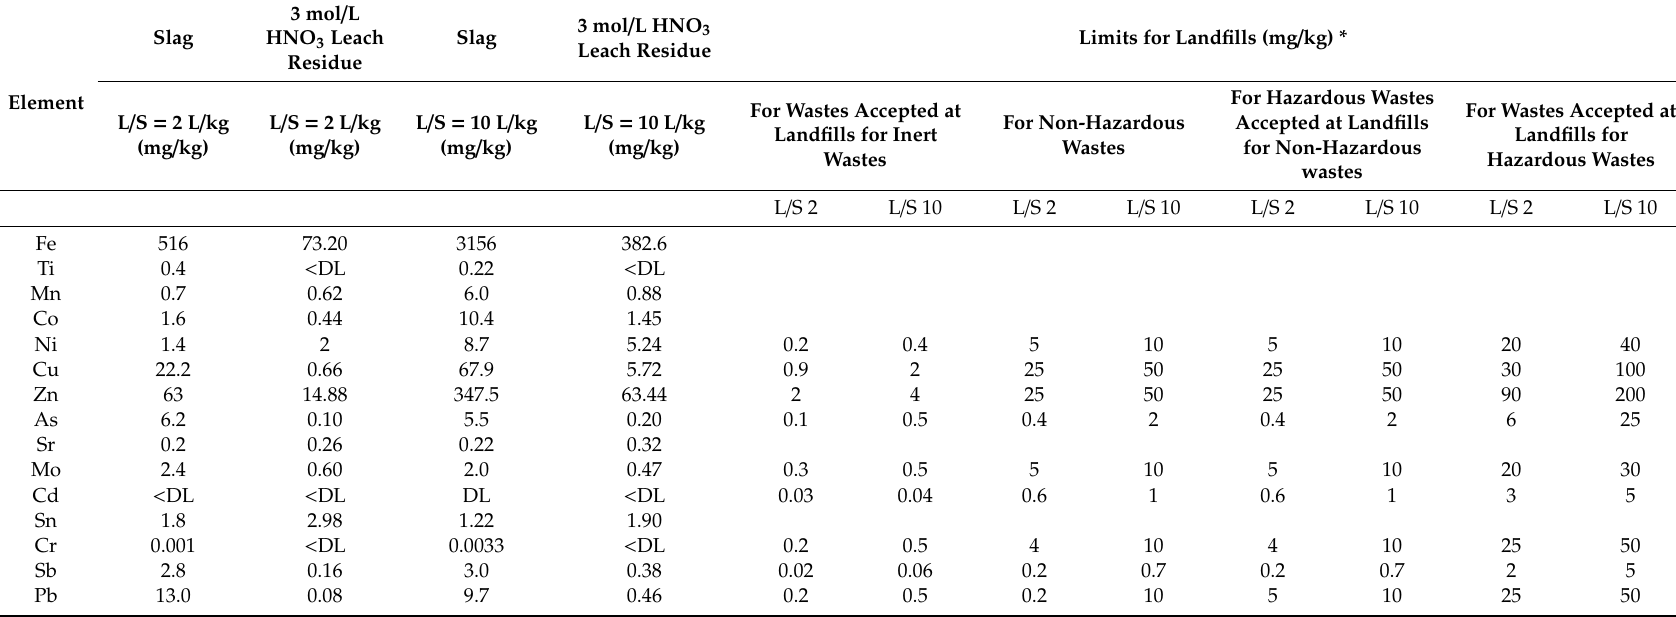
Table 4. EN 12457-3 results (L / S of 2 L / kg and 10 L / kg) for the original copper slag and its residue after leaching with HNO 3